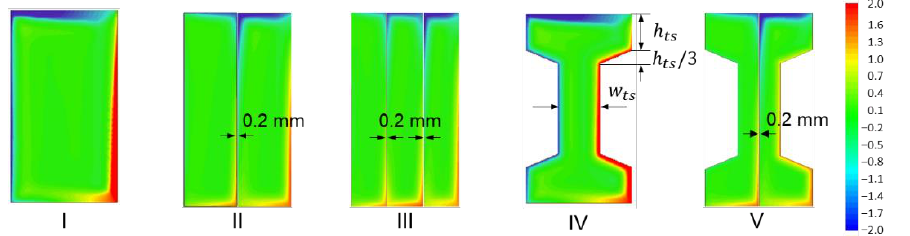
Figure 12. Map of the eddy current density for different MRSP cross-section shape (types I – V ); ℎ 𝑡𝑠 = 8.2 mm; 𝑤 𝑡𝑠 = 9.4 mm (type IV ); 𝑤 𝑡𝑠 = 9.6 mm (type V